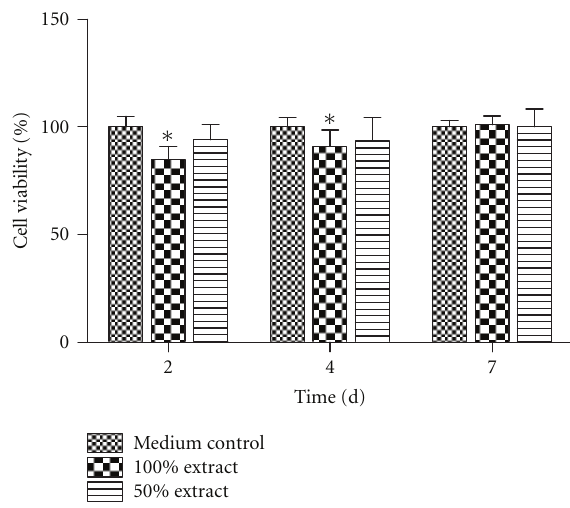
Figure 6: Cytotoxicity of microparticle measured by MTT assay. Each data point represents the mean of 8 samples ± SD, ∗ : compared with control P < 0 .